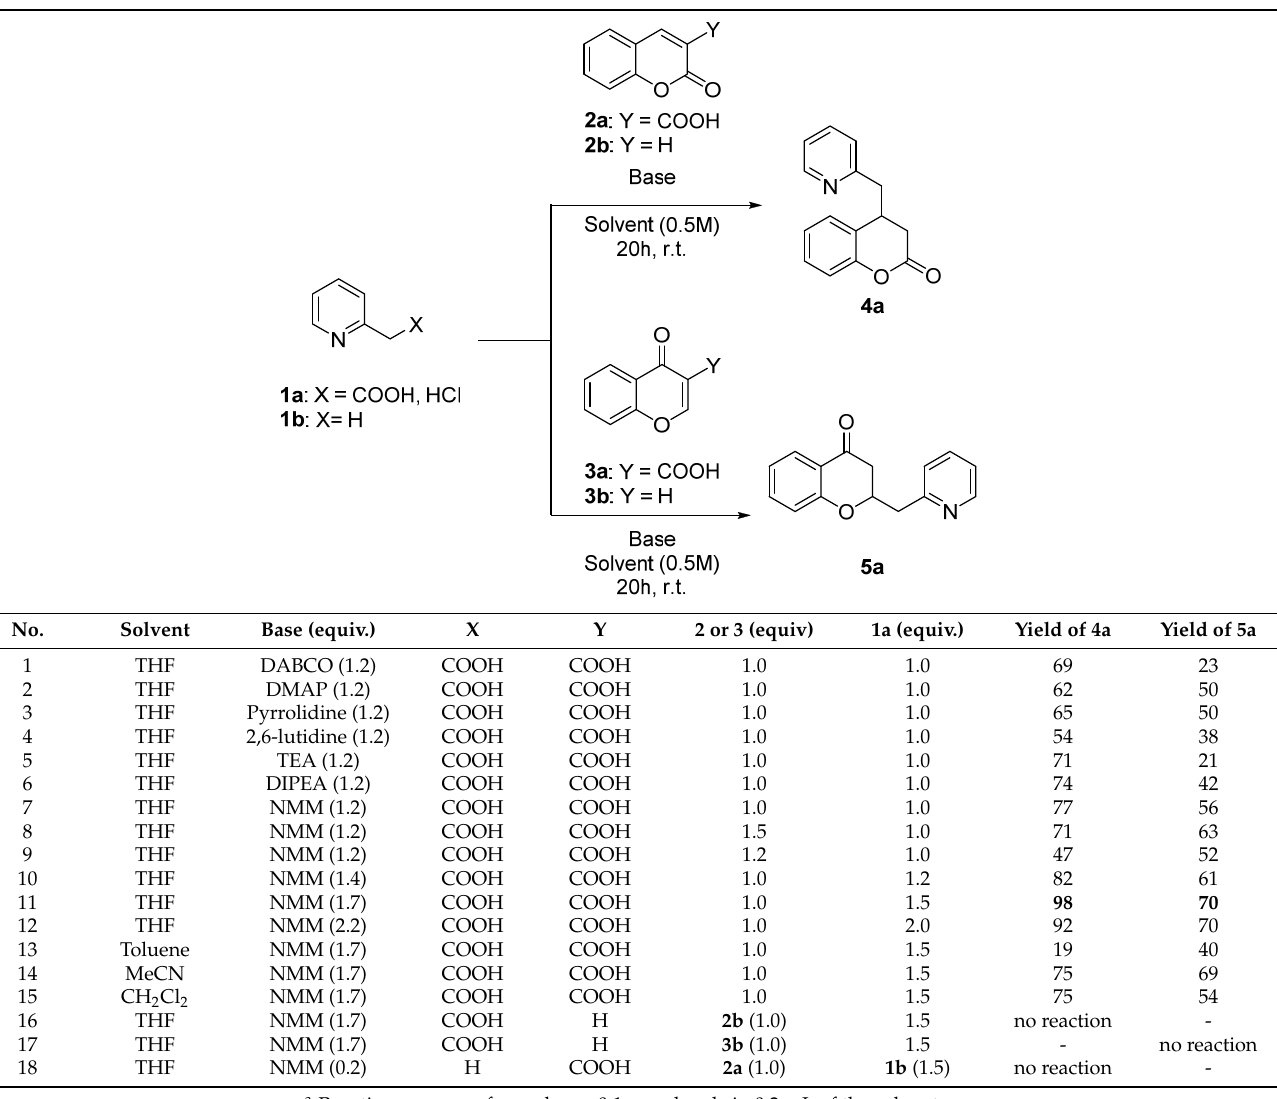
Table 1. Optimization studies of doubly decarboxylative synthesis of 4-(2-pyridylmethyl)chroman-2-ones 4 and 2-(4-pyridylmethyl)chroman-4-ones 5 a .